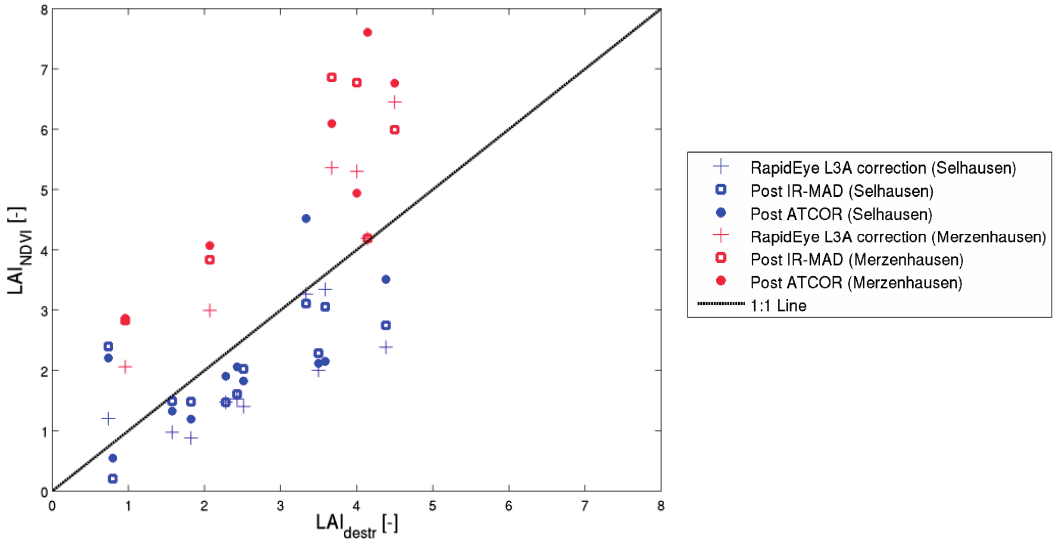
Figure 6. Scatter Plot of the LAI NDVI (RapidEye standard L3A, IR-MAD and ATCOR processed) with LAI destr for winter wheat field at Selhausen for 2011 and 2012 (blue) and at Merzenhausen for 2011